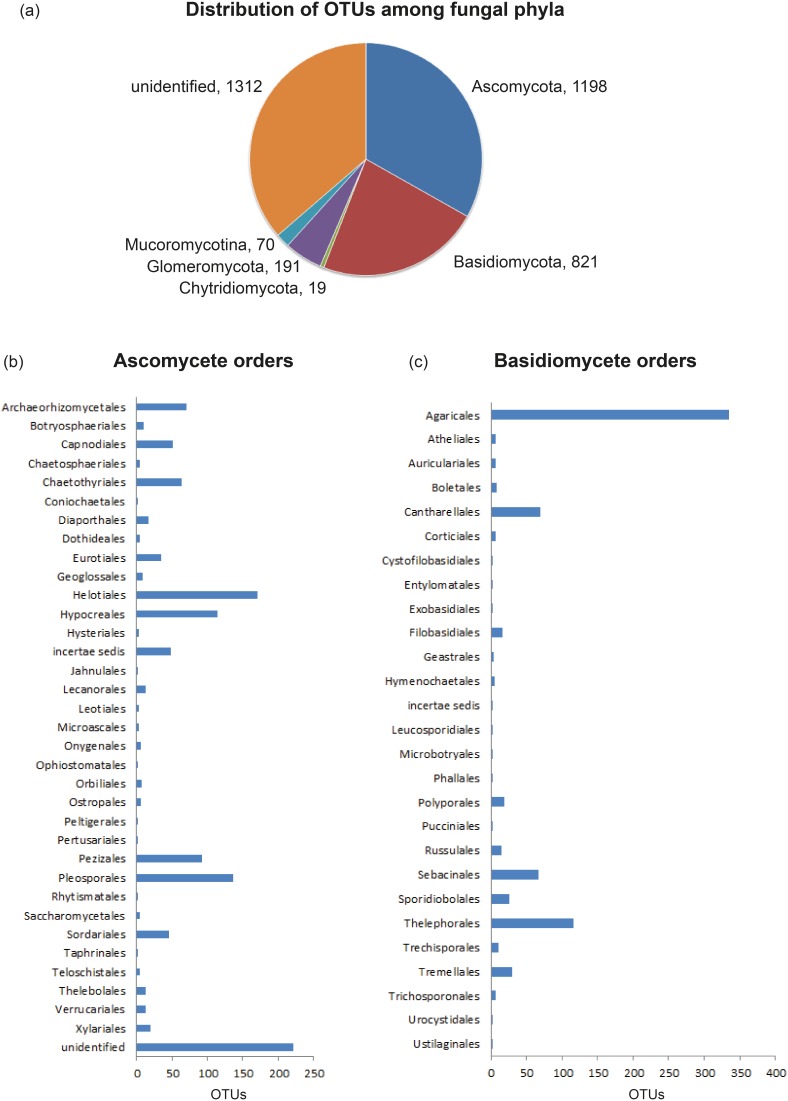
Taxonomic groupings of fungi retrieved from the samples.Proportional distribution of the 1022 unique BLASTN hits among different phyla and taxonomic orders in Basidiomycota and Ascomycota across all sampling sites based on sequences most closely related to 97% ITS OTUs in our sample.